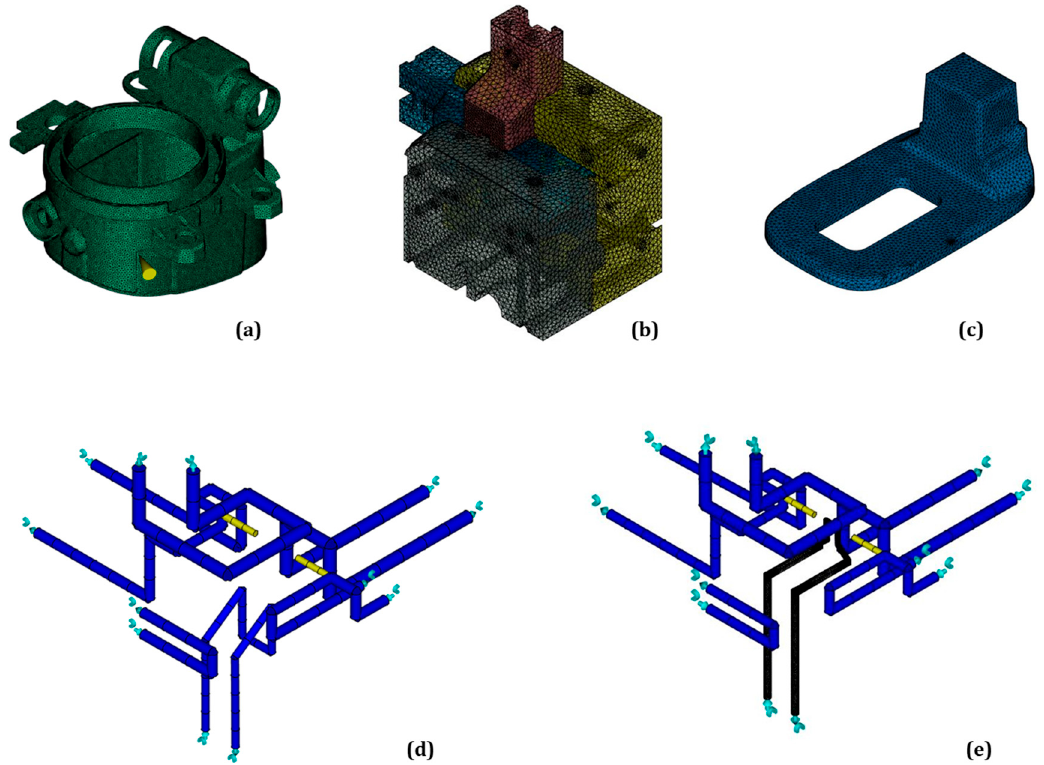
Figure 4. Mesh models of the product with injection location ( a ), the detailed tool ( b ), the top part of the tool core insert ( c ), the conventional cooling system with inlet and outlet boundaries ( d ), and the conformal cooling system ( e ).